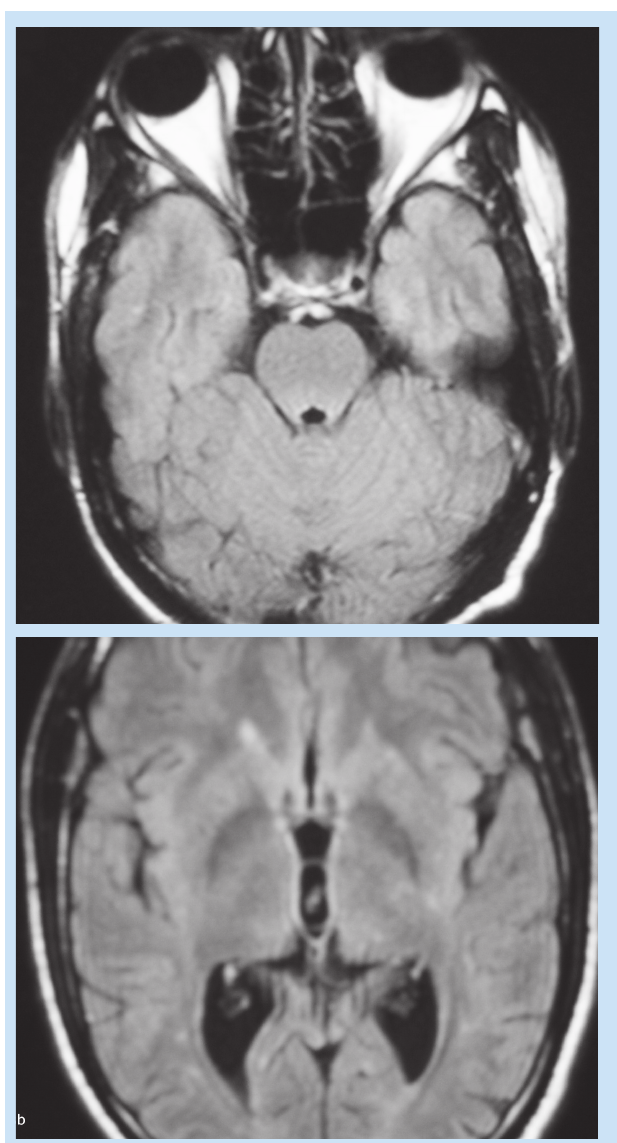
Figs. 3a and b. Follow-up axial FLAIR MR images showing a 3rd ventricu- lar neurocysticercus cyst and scolex not present at initial MRI. The previ- ously abnormal 4th ventricle has returned to its normal